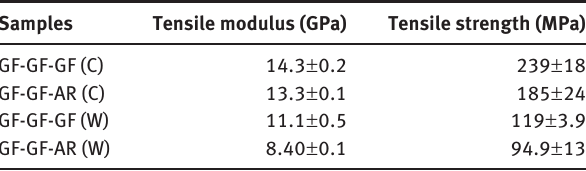
Table 2 Experimental results from the tensile test.